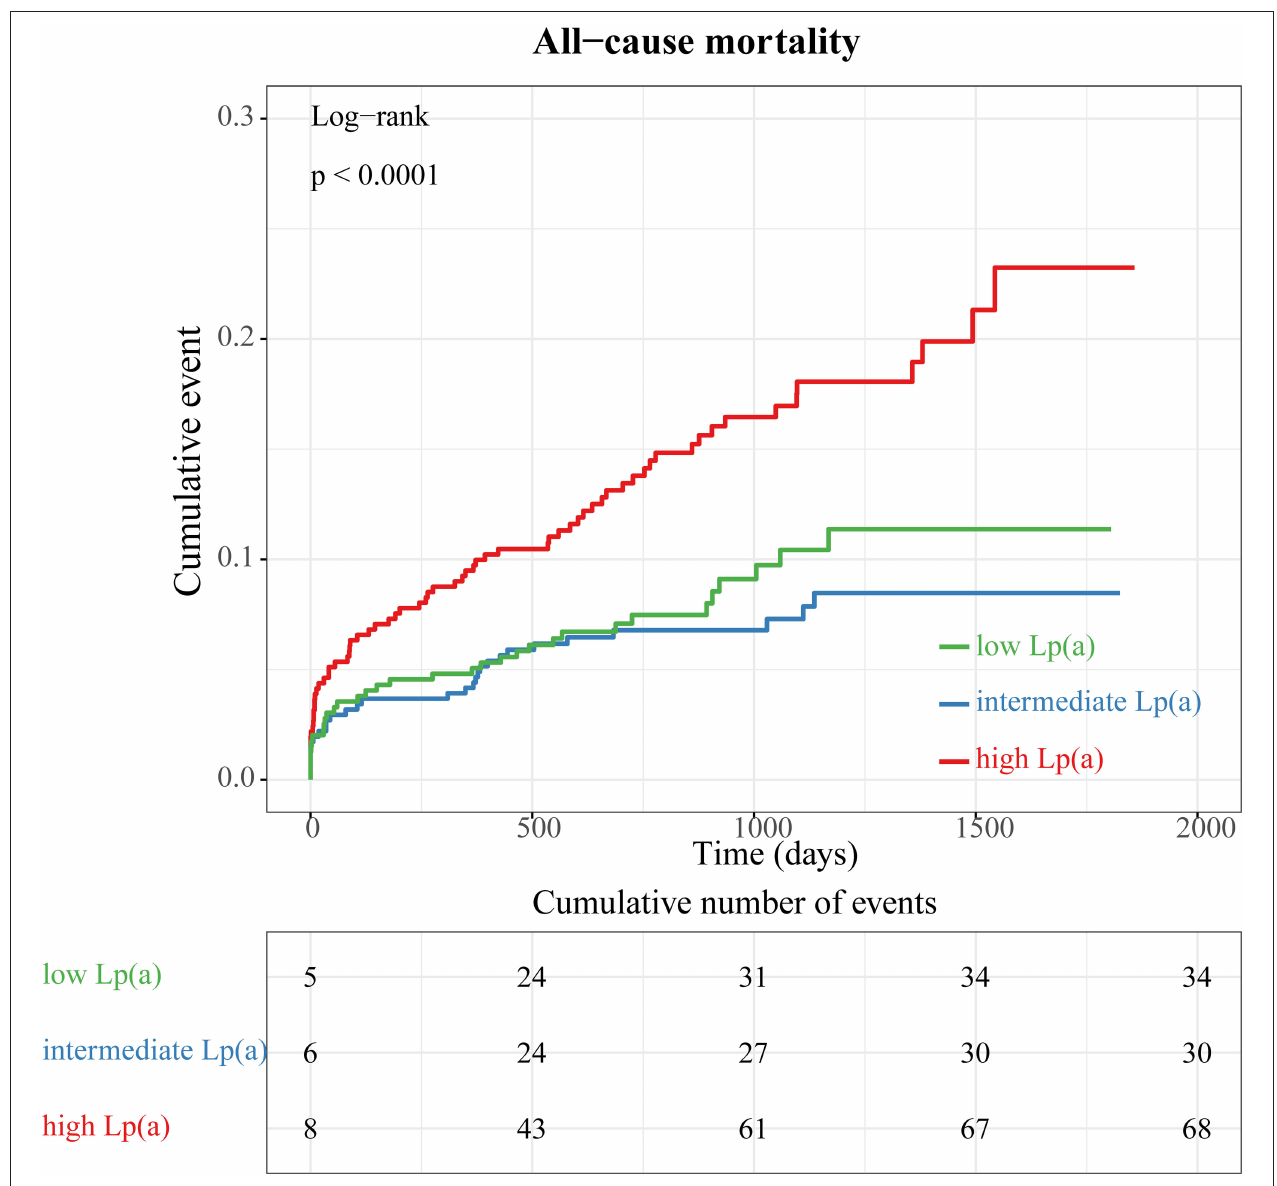
FIGURE 3 | Kaplan–Meier survival curves according to tertiles of lipoprotein (a) concentrations (all-cause